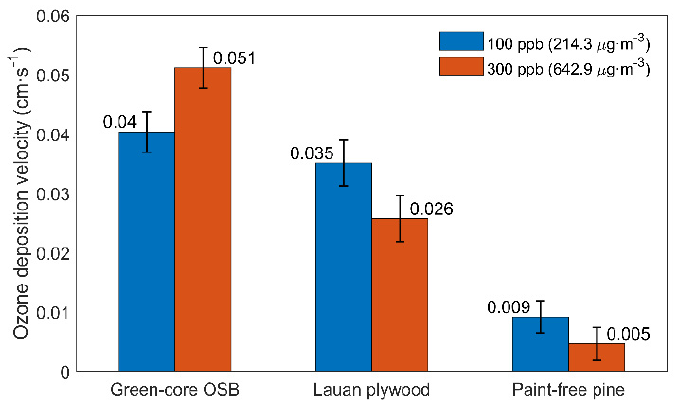
Figure 3. Ozone deposition velocities at a steady state on wood-based panels.